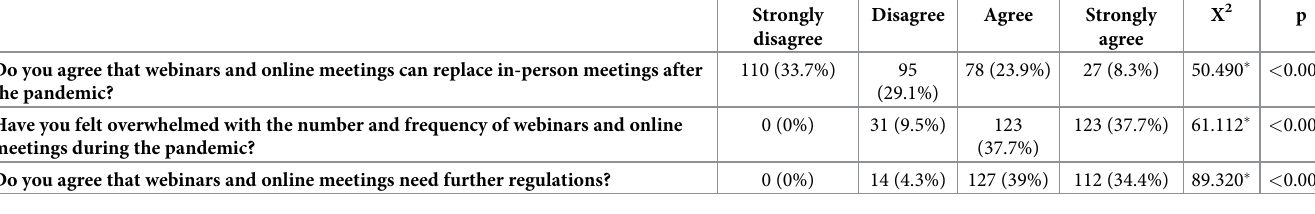
Table 4. Distribution of the survey responses according to agreeableness to different items (n = 326).